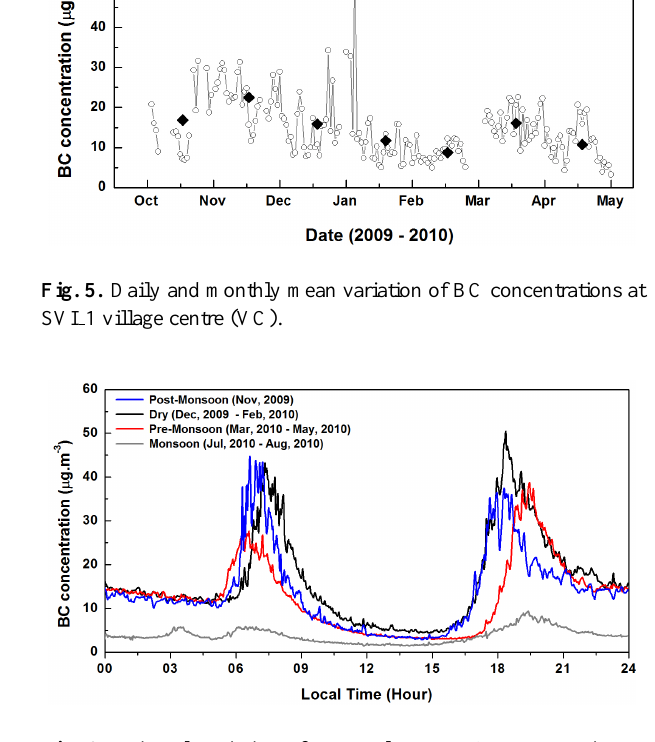
Fig. 6. Diurnal variation of seasonal mean BC concentration at SVI 1 village centre